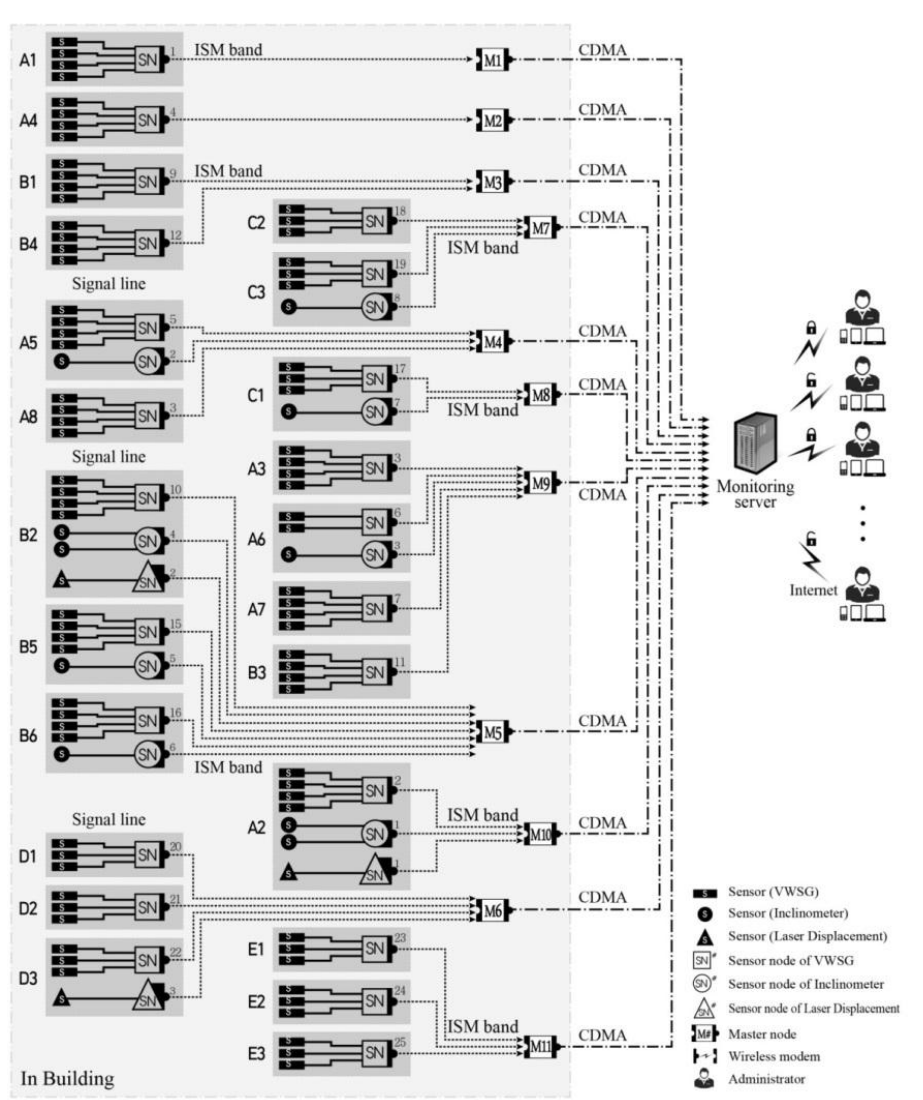
Figure 8. General designation method for communication at